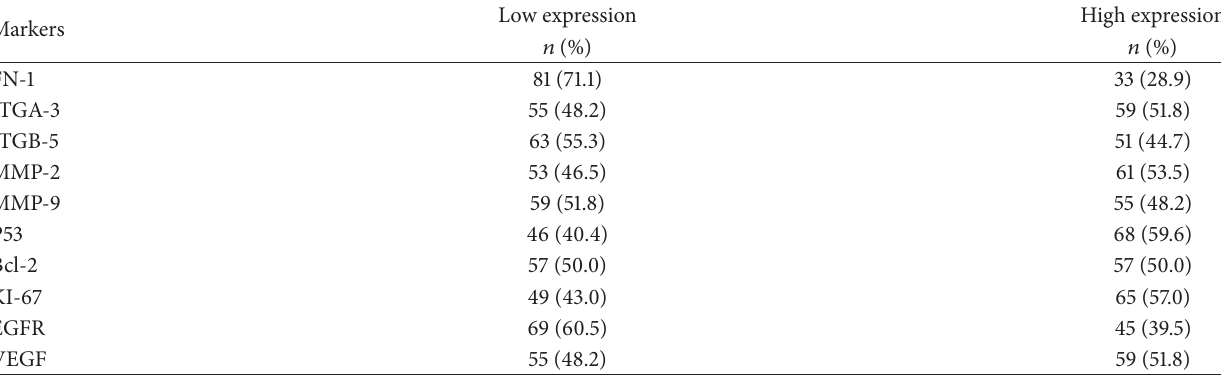
Table 10: The distribution of expression levels per IHC of proteins corresponding to ITGB-5, ITGA-3, MMP-2, MMP9, and FN-1 ECM genes and EGFR, VEGF, KI-67, P53, and Bcl-2 molecules as per the degrees of high and low expression of CRC ( 𝑛 = 114 ).